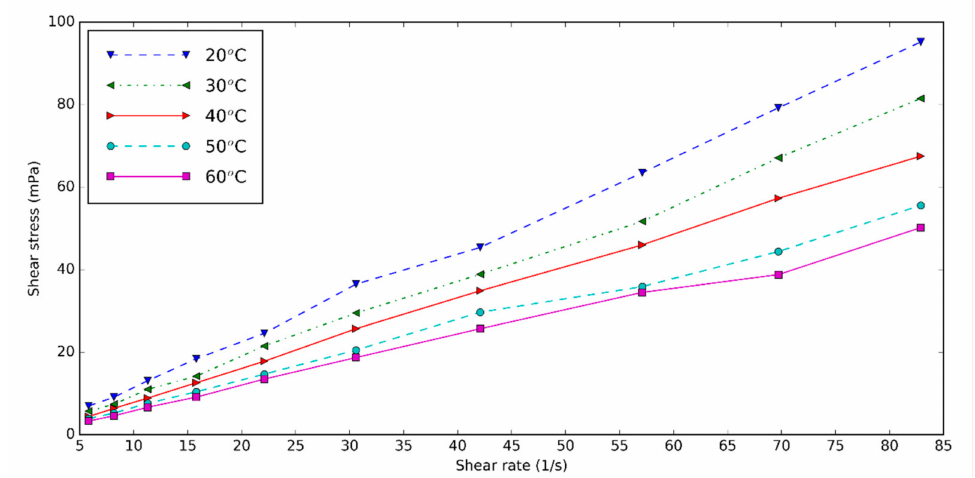
Figure 6. Shear stress–shear rates diagram of nanofluids for concentration of